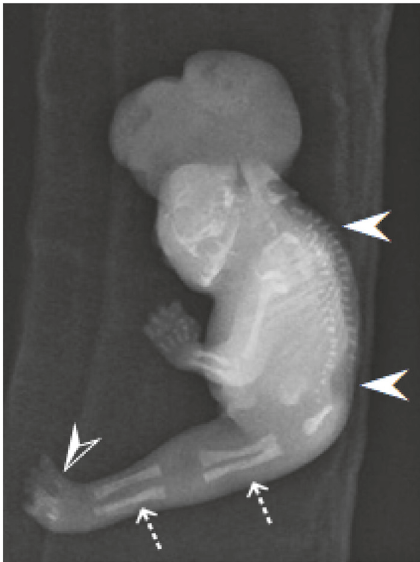
Figure 4: Autopsy imaging by radiography. The radiographs demonstrated complete rachischisis (white arrowheads) and the single lower limb containing two femora and two tibiae (white dashed arrows) and some metatarsals and phalanges (white open